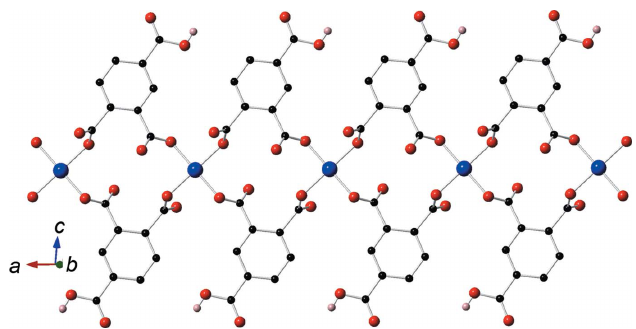
Figure 2 [Cu(btcH) 2 ] n 2 n (cid:2) coordination polymer ribbon parallel to [100] in the title compound.